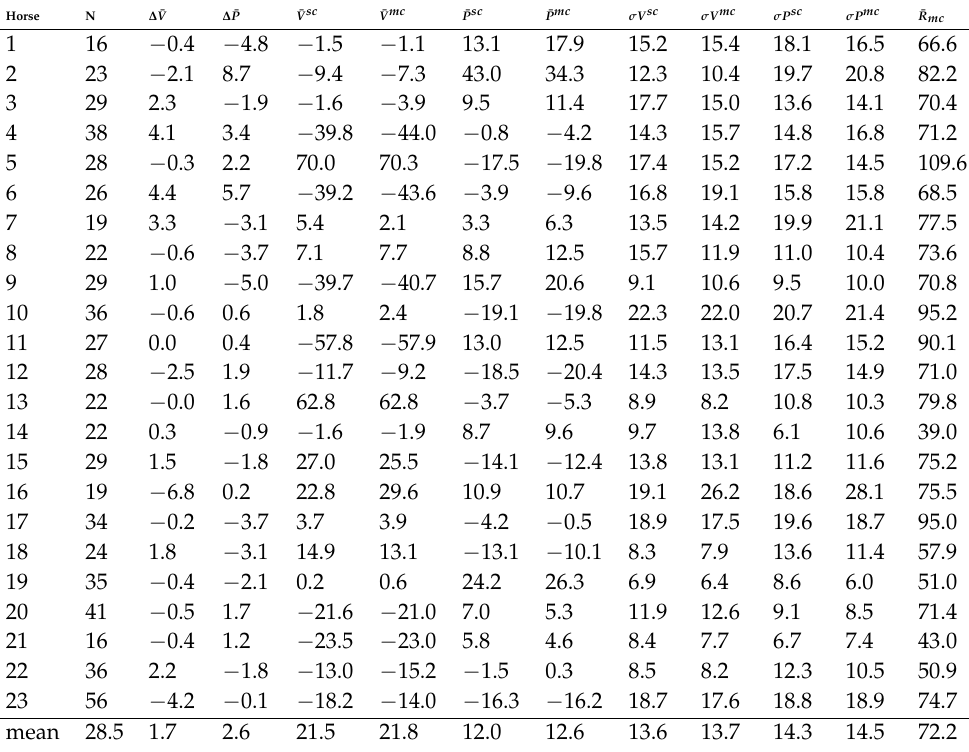
Table 1. Descriptive statistics for head measurements from the 23 included horses showing number of matched strides per trial (N) and the mean trial deviations between the two systems for the valley values ∆ ¯ V (MinDiff) and peak values ∆ ¯ P (MaxDiff). Also, the actual trial means for the ¯ V (MinDiff) and the ¯ P are presented per trial for the multi-camera marker-based ( mc ) and the single-camera markerless ( sc ) systems, followed by their within trial standard deviation ( σ V and σ P ). From the mc , the trial mean range of motion of the vertical displacement signal is presented.